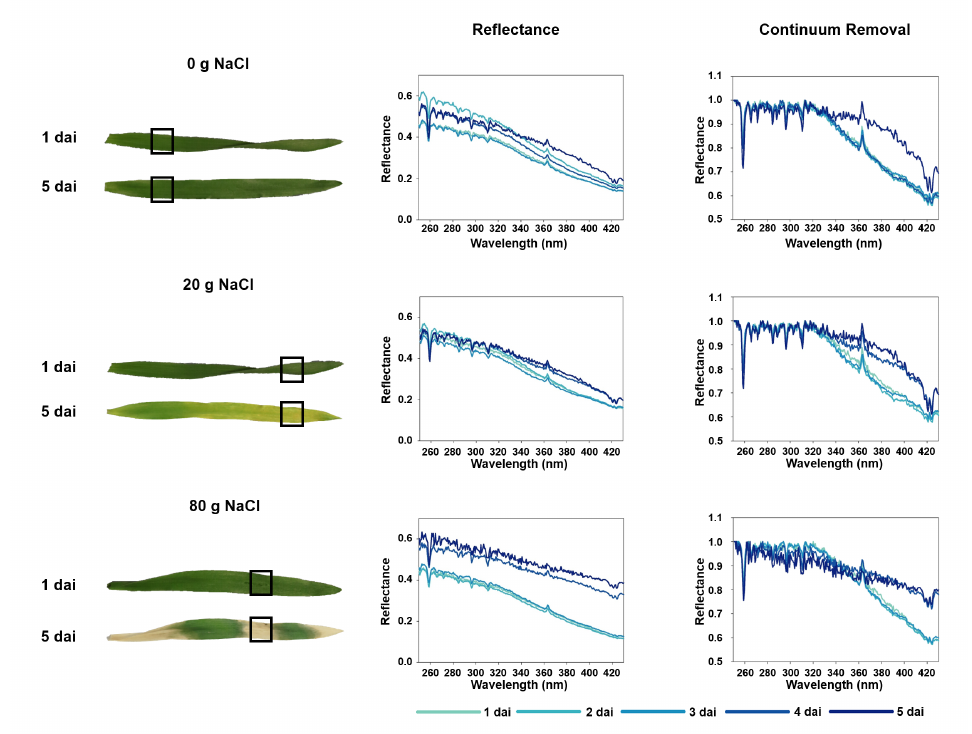
Figure 4. Spectral signatures of barley leaves on 0 g, 20 g, 80 g NaCl/l phytoagar from 1–5 days after incubation, corresponding continuum removal and RGB images of one and five